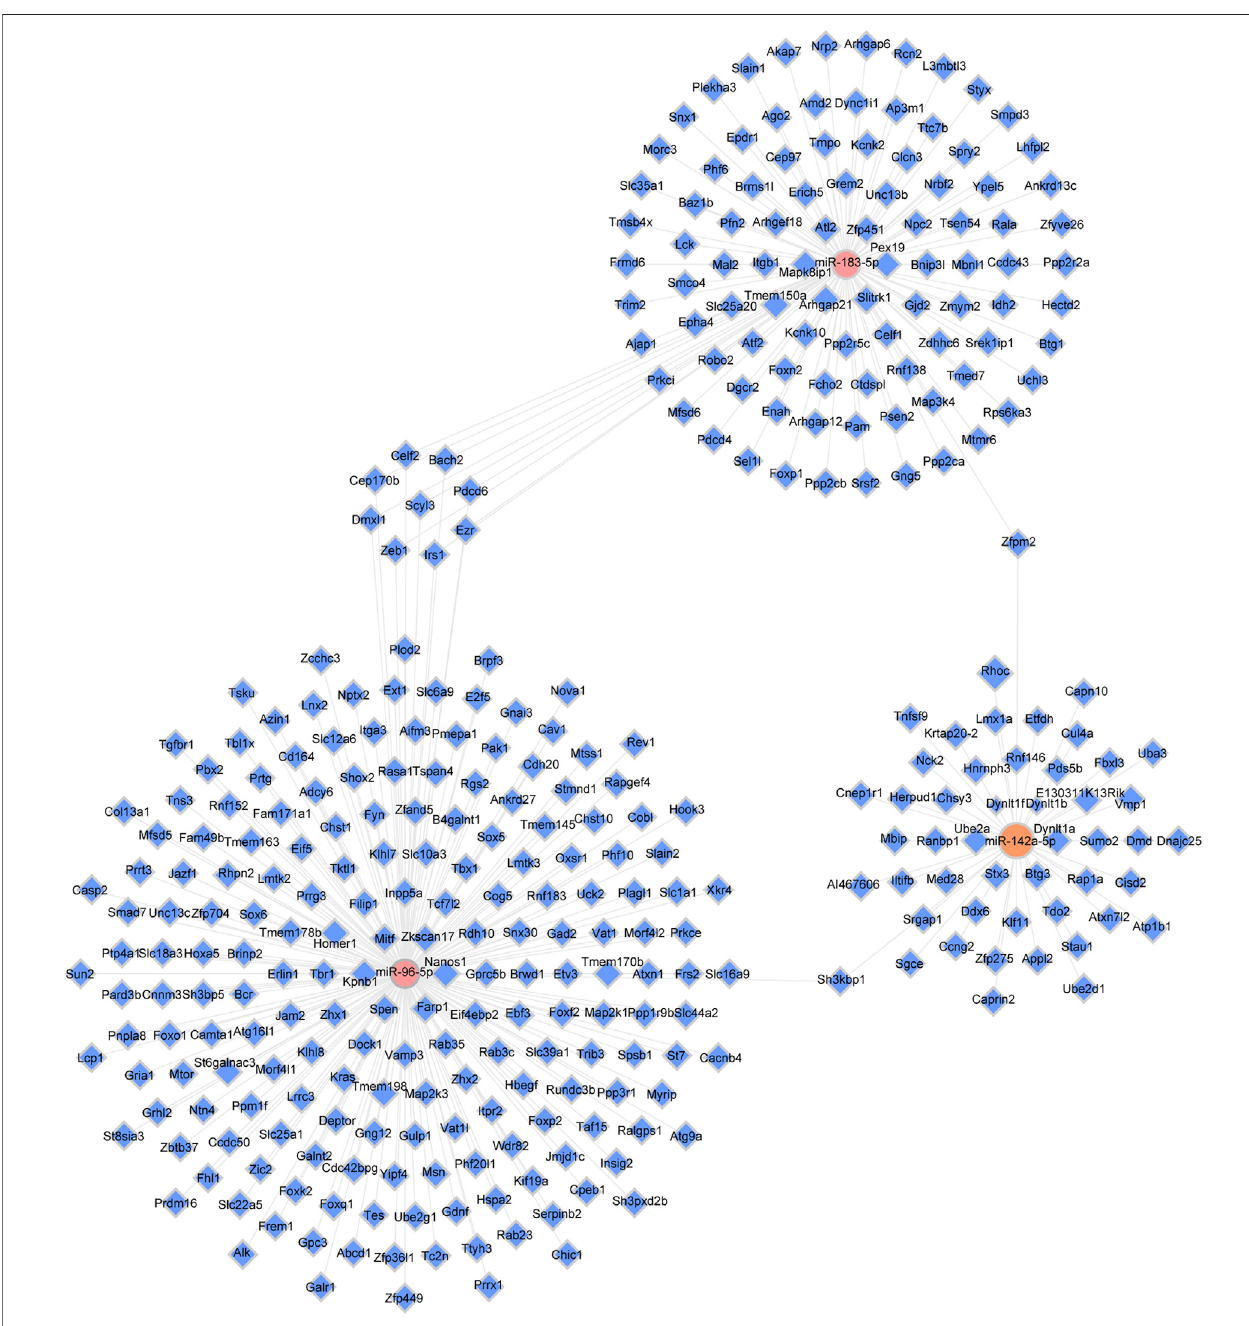
FIGURE 5 | The miRNA-target genes network. Pink dots represent upregulated miRNAs (miR-96-5p and miR-183-5p); orange nodes represent downregulated miRNAs (miR-142a-5p); blue dots represent target genes, and solid gray lines illustrate correlations between miRNAs and target genes.